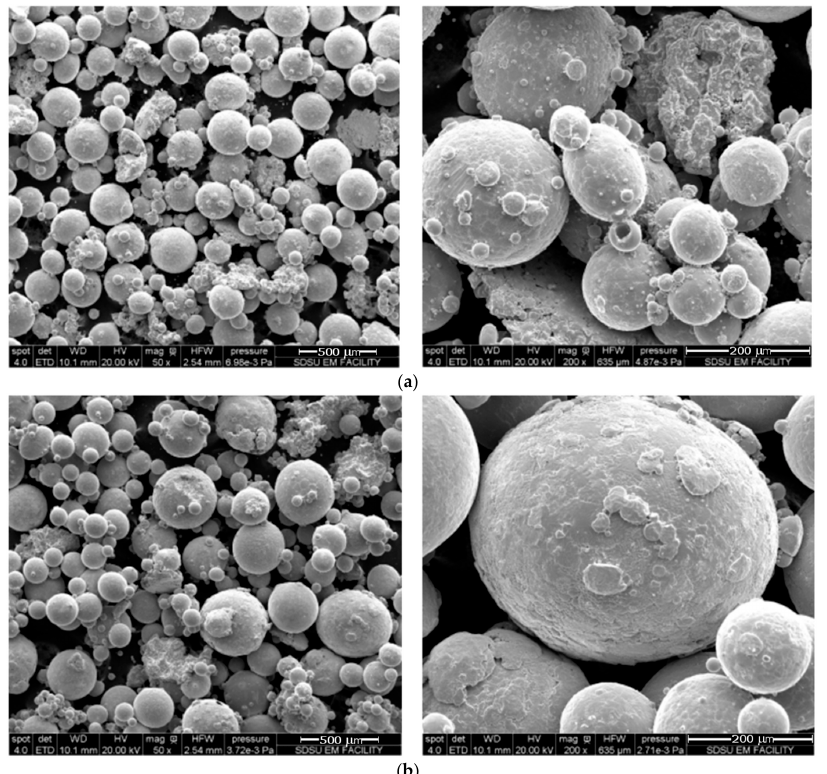
Figure 2. SEM images of ( a ) 150 μ m TNZT powder (50× and 200×) and ( b ) 300 μ m TNZT powder (50× and 200×).